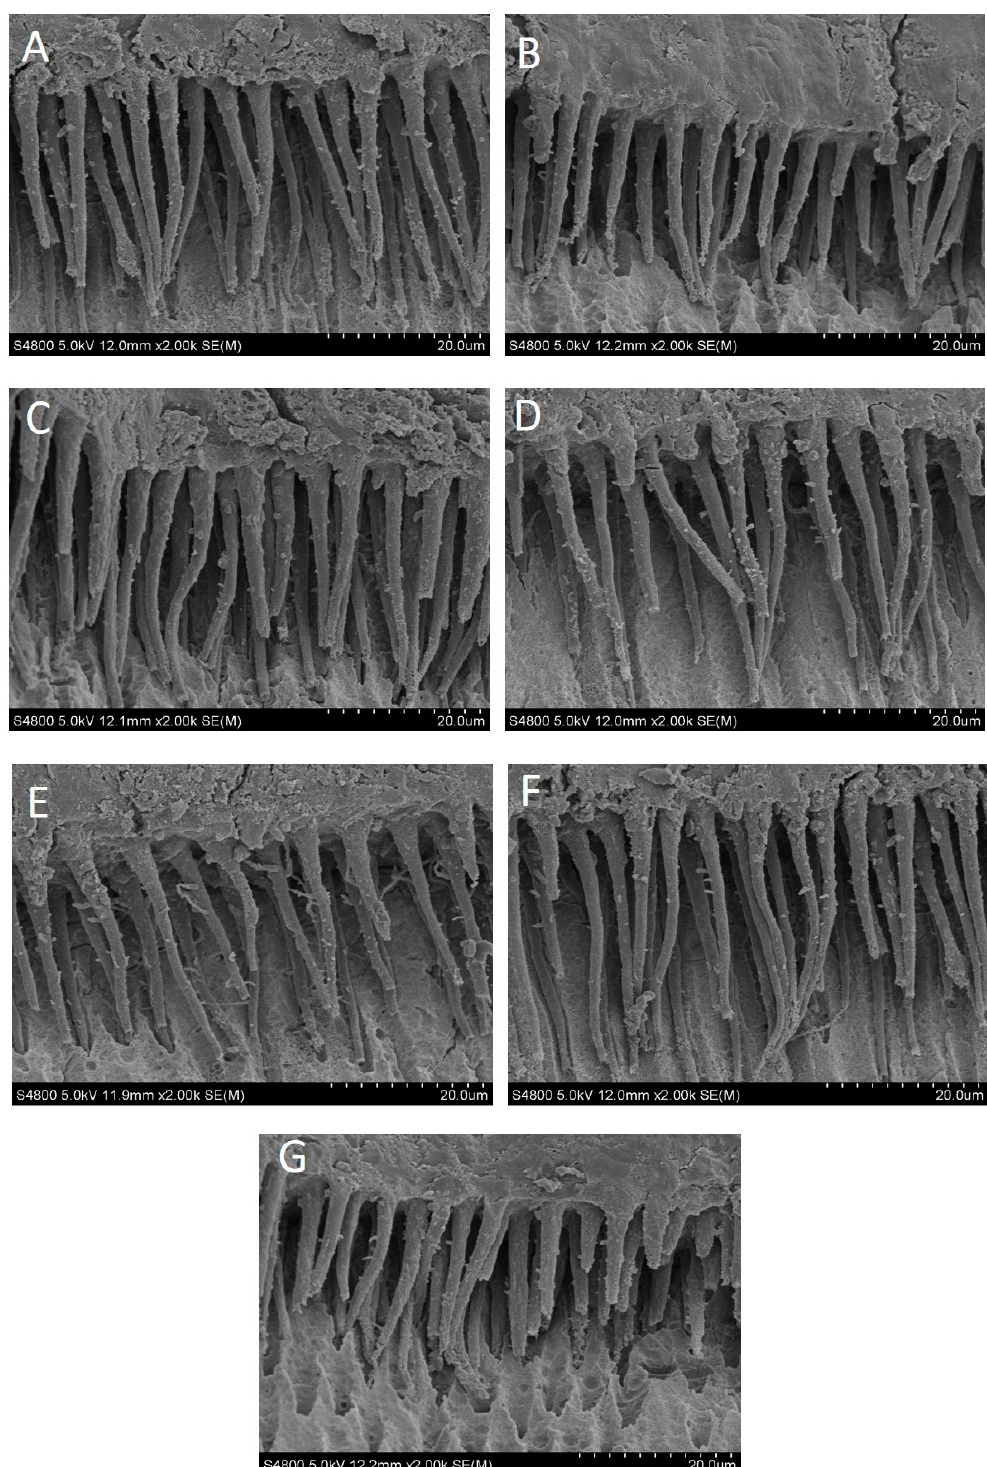
Figure 2. Representative SEM micrographs of the resin–dentin interface obtained after 24 h storage of specimens treated with different concentrations of ethanol-based EDC in 0.9% NaCl solution. Original magnification ×2000. ( A ) No treatment (control) group; ( B ) ethanol treatment group; ( C ) 0.01 M EDC treatment group; ( D ) 0.1 M EDC treatment group; ( E ) 0.3 M EDC treatment group; ( F ) 0.5 M EDC treatment group; ( G ) 1.0 M EDC treatment group.